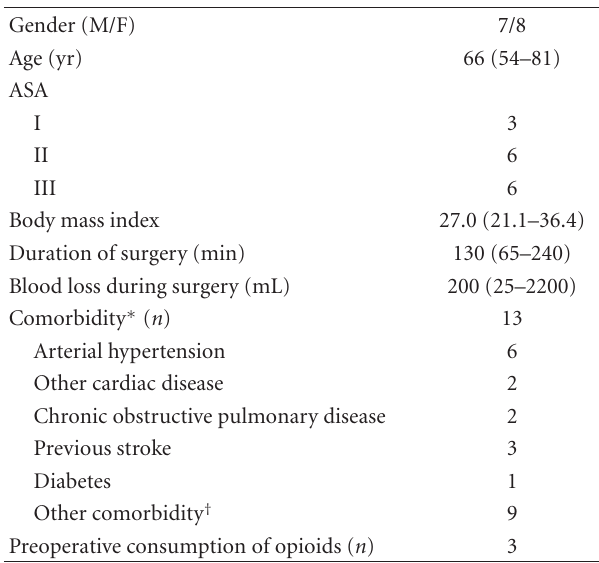
Table 1: Baseline characteristics ( n = 15).